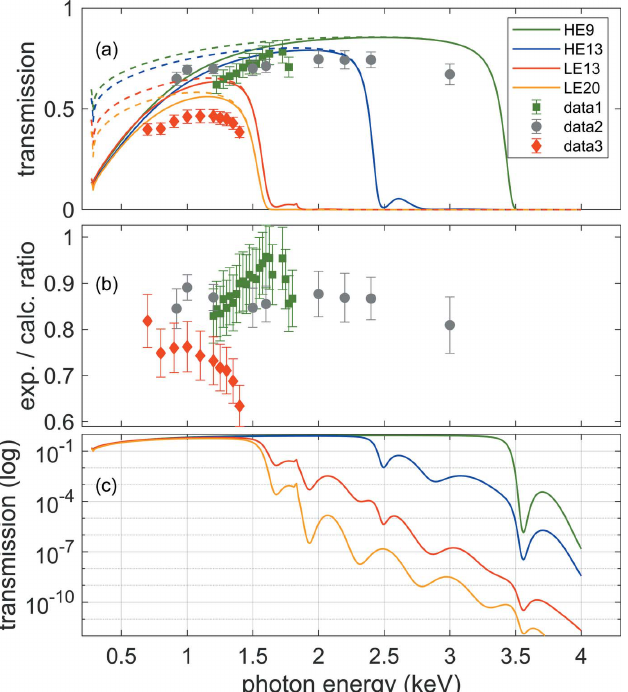
Figure 2 ( a ) Calculated and measured beamline transmission, including all six optical elements, as a function of photon energy for different beam transport configurations. The dashed curves represent the reflectivity contribution to the transmission, whereas the full lines represent the total transmission given by the product of the reflectivity and the geometric acceptance contributions. Different colors of the curves correspond to different incidence angle settings for the horizontal (H) and vertical (V) chicanes. Yellow: H = 20 mrad, V = 20 mrad; red: H = 13 mrad, V = 20 mrad; blue: H = 13 mrad, V = 9 mrad; green: H = 9 mrad, V = 9 mrad. The points represent transmission measurements. Green squares (‘data1’): H = 9 mrad, V = 9 mrad; gray circles (‘data2’): H = 9 mrad, V = 9 mrad, probing reflectivity only (see text); red diamonds (‘data3’): H = 13 mrad, V = 20 mrad. ( b ) Ratio between the measured and the respective calculated transmission values shown in ( a ). ( c ) Calculated beamline transmission, in logarithmic scale, showing the transmission above the cut-off energy, which determines the fraction of the original higher harmonics contribution from the undulator, which is delivered to the experiment (Baumann et al. ,